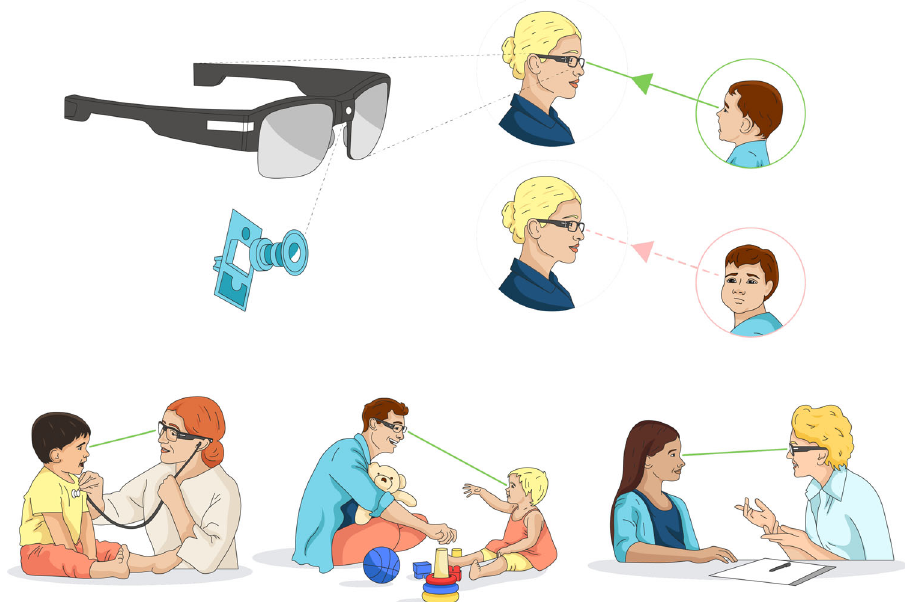
Fig. 1 Overview of the approach. Wearable glasses with a small outward-facing camera embedded in the bridge are used to record the face of the camera wearer ’ s interactive partner. By virtue of its placement, gaze during eye contact is directed toward the camera, and is captured in video, enabling automated detection. Due to its ease of use, the approach can be widely deployed in a variety of settings, as illustrated in the fi gure, for which eye tracking may be infeasible due to cost, burden, compliance, or distraction